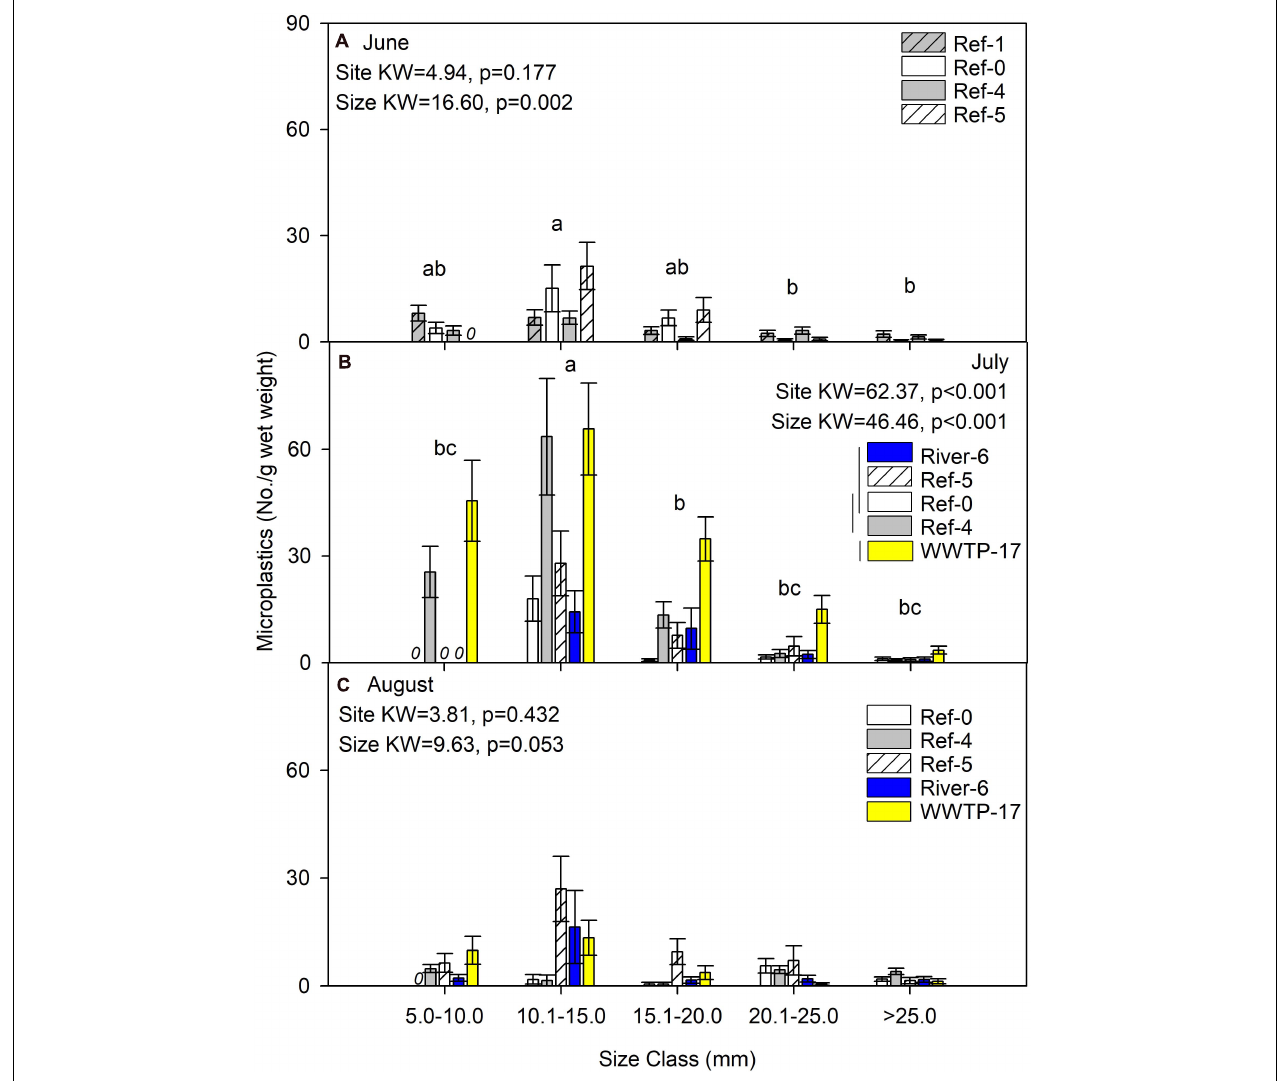
FIGURE 3 | Mean ( ± SE) microplastic concentration (No./g wet weight) in dreissenid mussels from Milwaukee Harbor in (A) June, (B) July, and (C) August 2018. K–W test results are shown in each panel, where df for size class = 4 in all panels, and df for site = 3 in panel (A) and df = 4 in panels (B,C) . In each panel, means with the same lowercase letter are not significantly different among size classes after post hoc comparisons ( p ≤ 0.05). Overlapping vertical lines next to the site legend are not significantly different after post hoc comparisons ( p ≤ 0.05). Ref, reference; WWTP, wastewater treatment